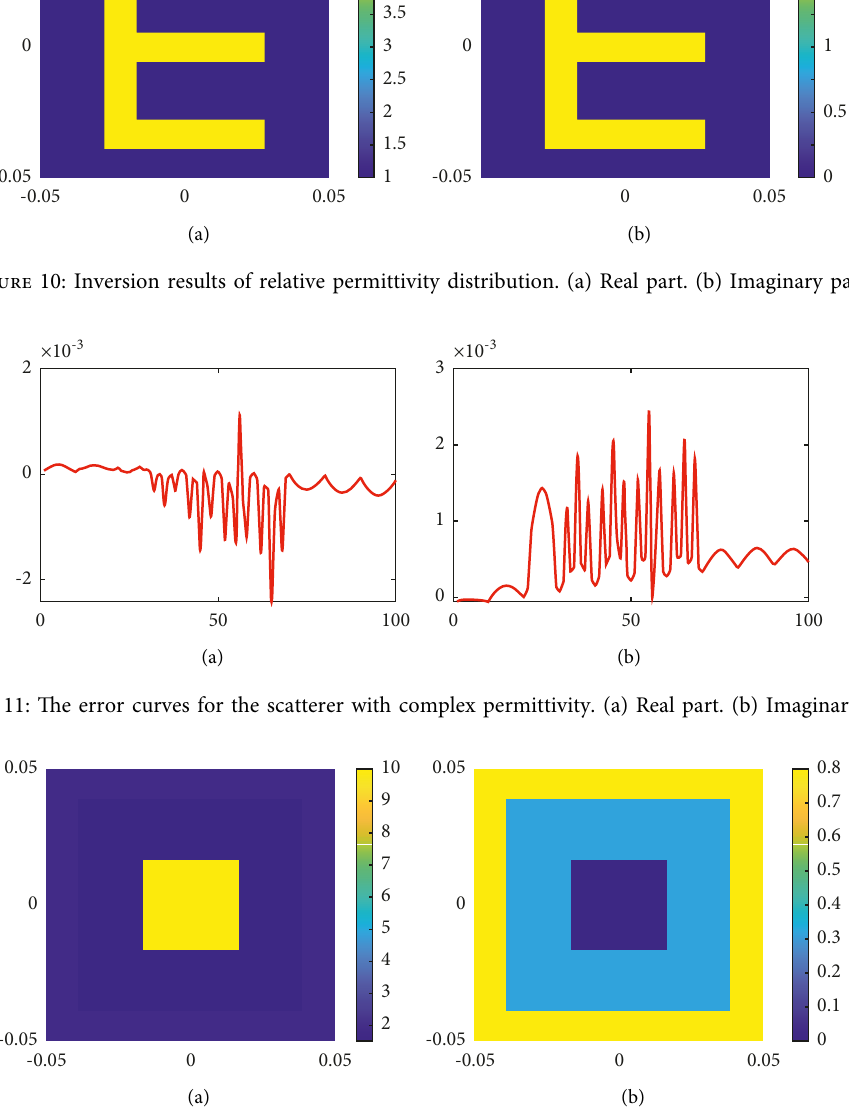
Figure 12: Relative permittivity distribution of the scatterer in non-free space. (a) Real part. (b) Imaginary part.